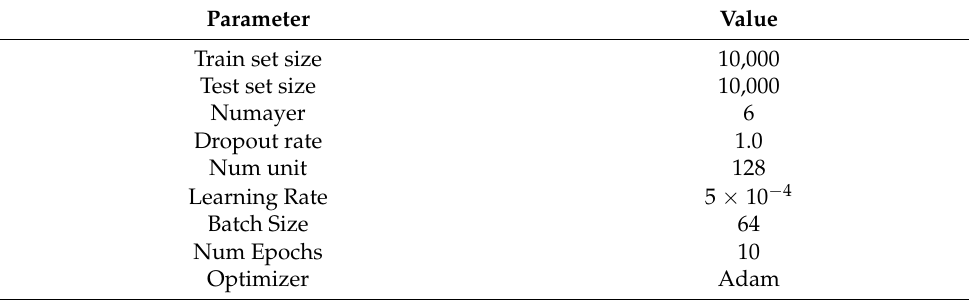
Table 2. Experimental settings in Deep Learning.